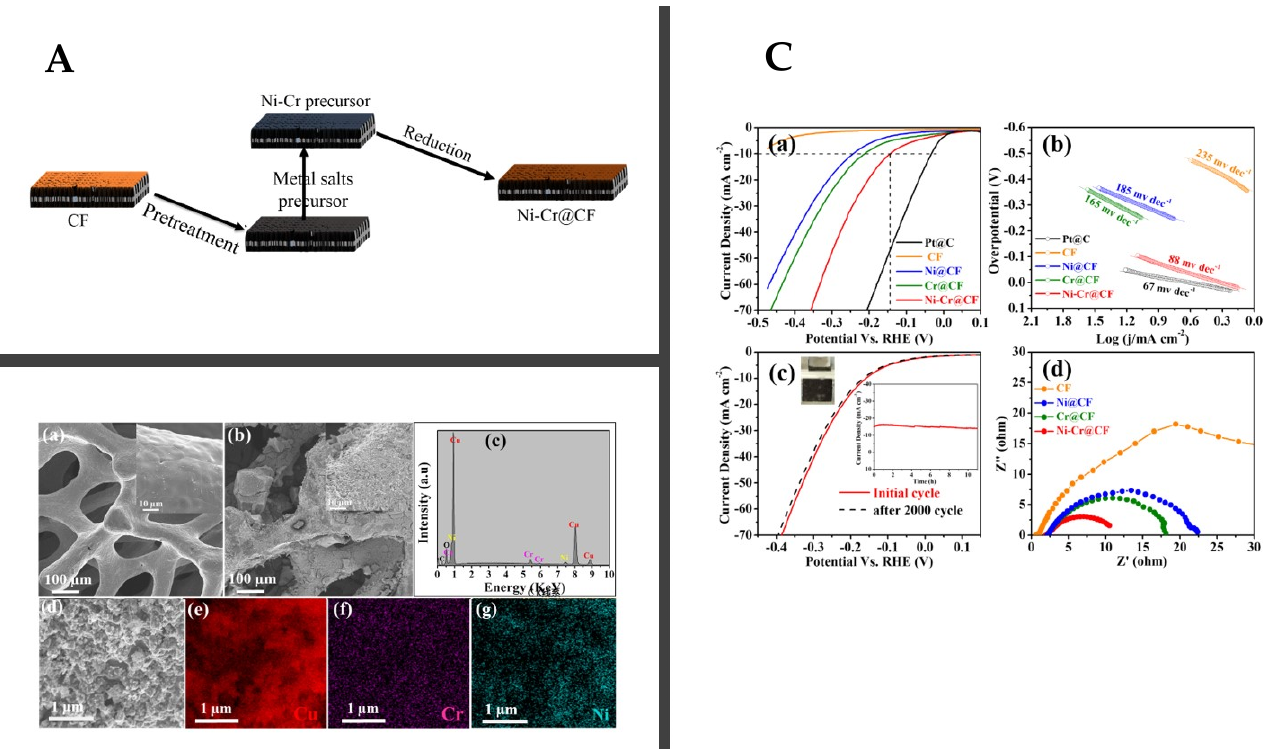
Figure 4. ( A ) Schematic illustration for the surface-modified Ni − Cr@CF, ( B ) corresponding SEM images ( a , b ) and elemental mapping of the selected area ( c – g ), ( C ) Prepared Ni − Cr@CF electrocatalyst with efficient HER performance, Tafel slope, stability test and Electrochemical impedance spectra (EIS) respectively ( a – d ). Reprint from [122]. Copyright (2021), with permission from Elsevier.